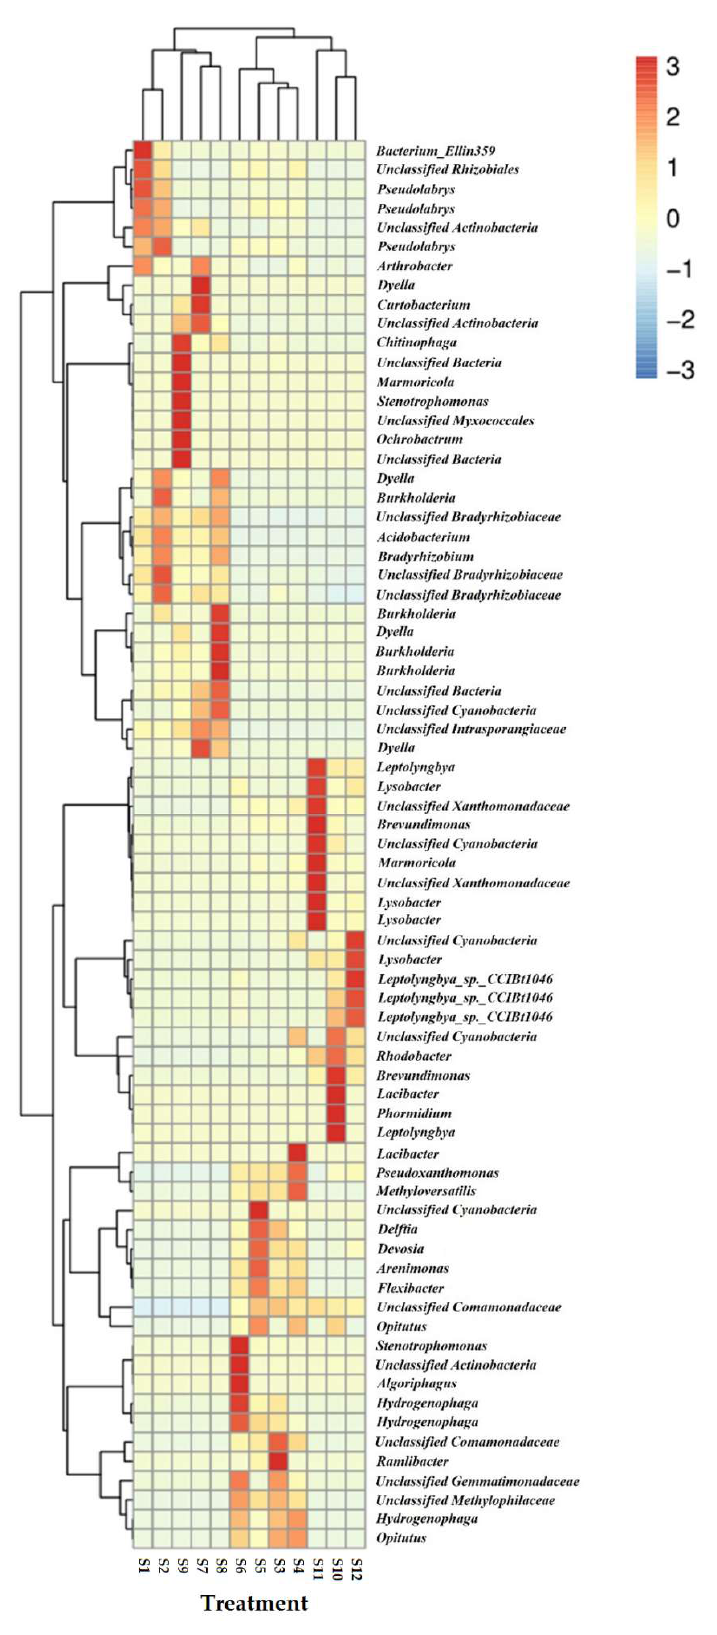
Figure 3. Heatmap of the relative abundance of the top 10 predominant genera in each treatment. Refer to Figure 1 for treatment details. Each value is the mean of four replicates ± SEM.